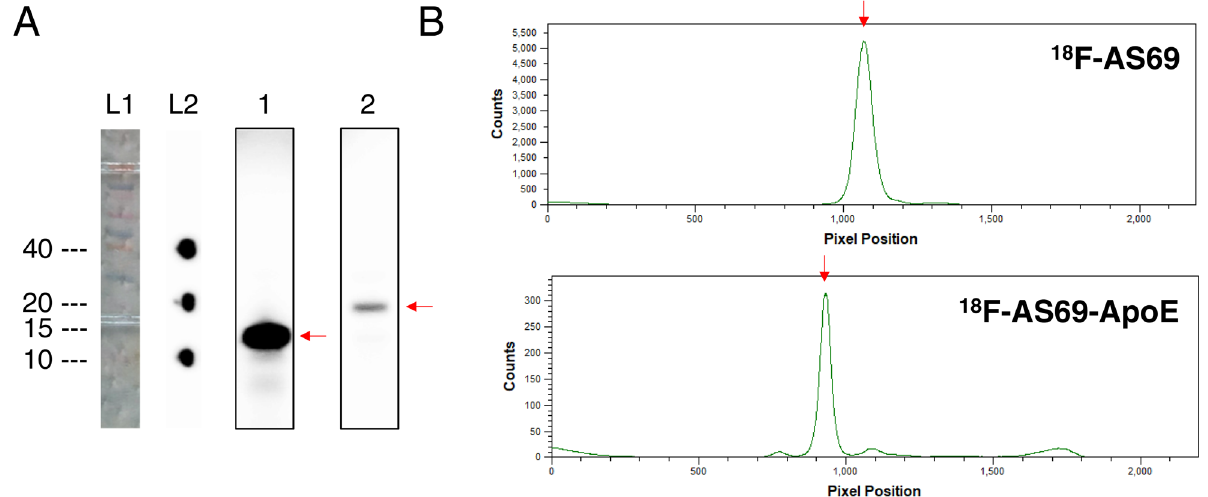
Figure 3. Radiochemical purities of 18 F-AS69 and 18 F-AS69-ApoE. (A) SDS-PAGE analysis of purified proteins. The molecular weights of 18 F-AS69 and 18 F-AS69-ApoE are 14 kDa and 22 kDa, respectively. Ladder 1 (L1): original ladder lane from a gel; Ladder 2 (L2): autoradiographic markers at the position of 10, 20, and 40 kDa ladder bands; Lane 1 and 2: the purified fractions of 18 F-AS69 and 18 F-AS69-ApoE, respectively. (B) Assessment of radiochemical purity via a gel image analysis from lane 1 and 2. Original autographic images and gels were shown in Fig. S1.